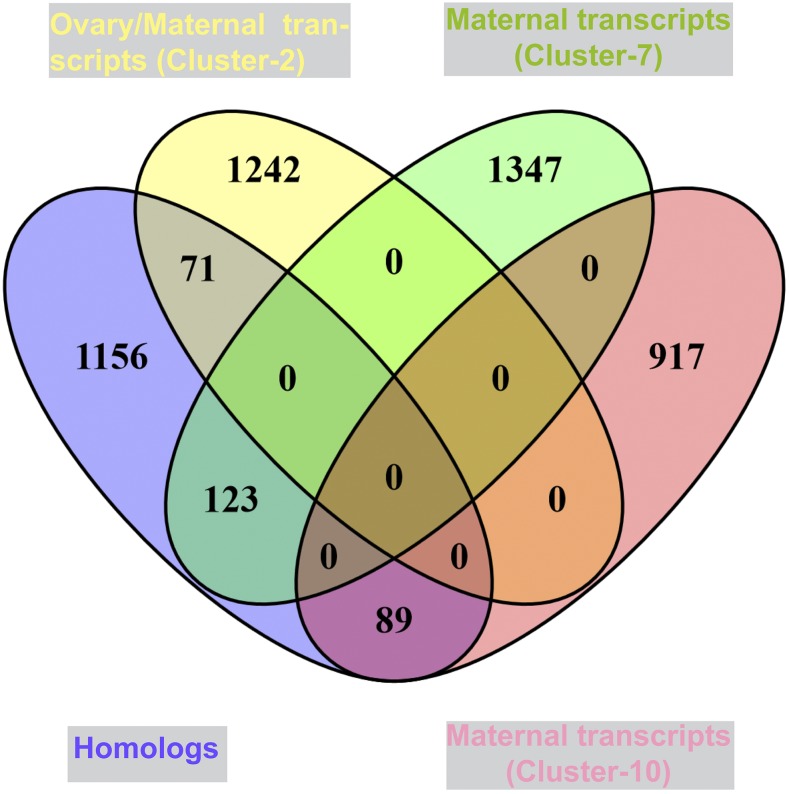
Cluster of highly co-expressed genes in the Tribolium ovary and embryo. Genes expressed and grouped together in the Tribolium ovary (maternal genes) is shown in Cluster-2 (yellow filled color oval). Genes co-expressed in the Tribolium embryo (0-5 hr) and ovary (maternal genes and reduced in expression rapidly) is shown in the Clusters-7 (green filled color oval). Genes co-expressed in both embryo stages and ovary is grouped together in Cluster-10, coral filled color oval (maternal genes). The purple filled color oval represents the known maternal genes. The overlap represents the known maternal genes in Tribolium.